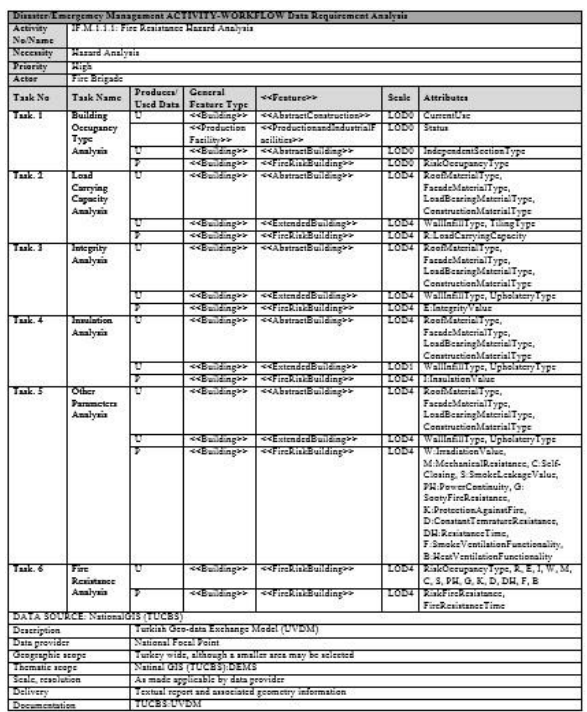
Table 1. Geo-information requirement analysis for the tasks of